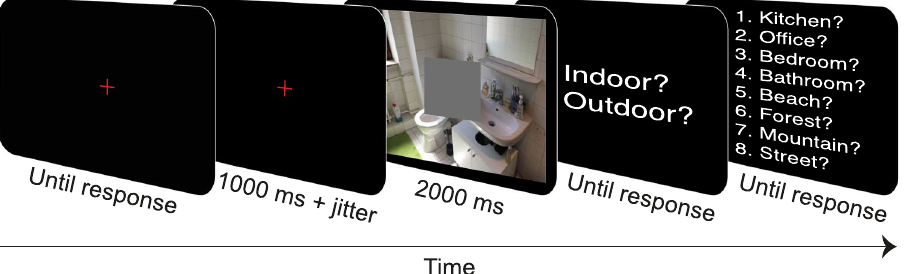
Figure 6. Trial sequence of the categorization experiment (slightly adapted for display purposes).